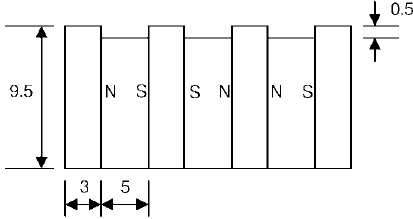
Figure 13 Type A structure for the first application.